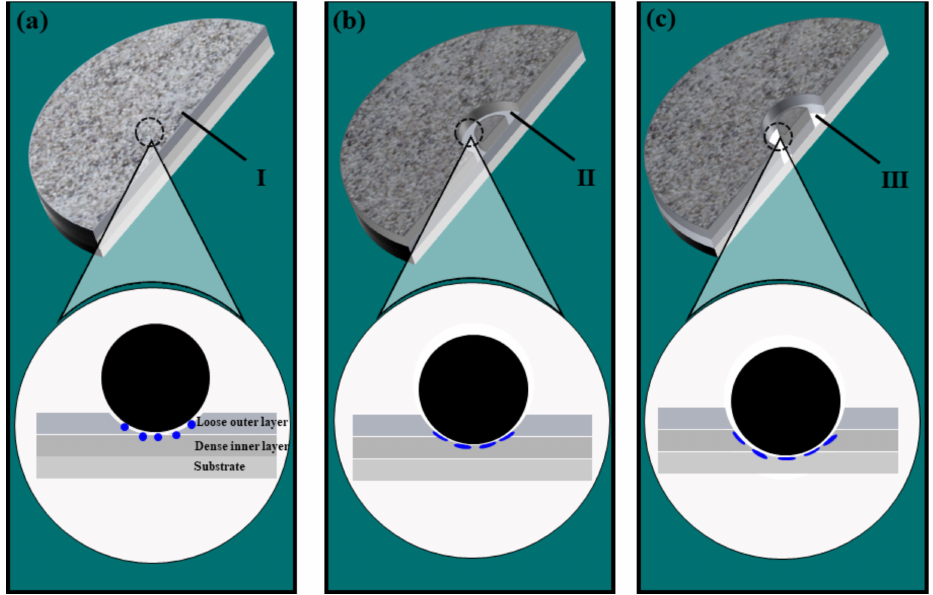
Figure 11. Wear mechanism diagram of prepared layer with Ti 3 SiC 2 and Ti 3 AlC 2 particles addition. ( a ) Friction Stage 1. ( b ) Friction Stage 2. ( c ) Friction Stage 3. I Loose outer layer. II Dense inner layer. III